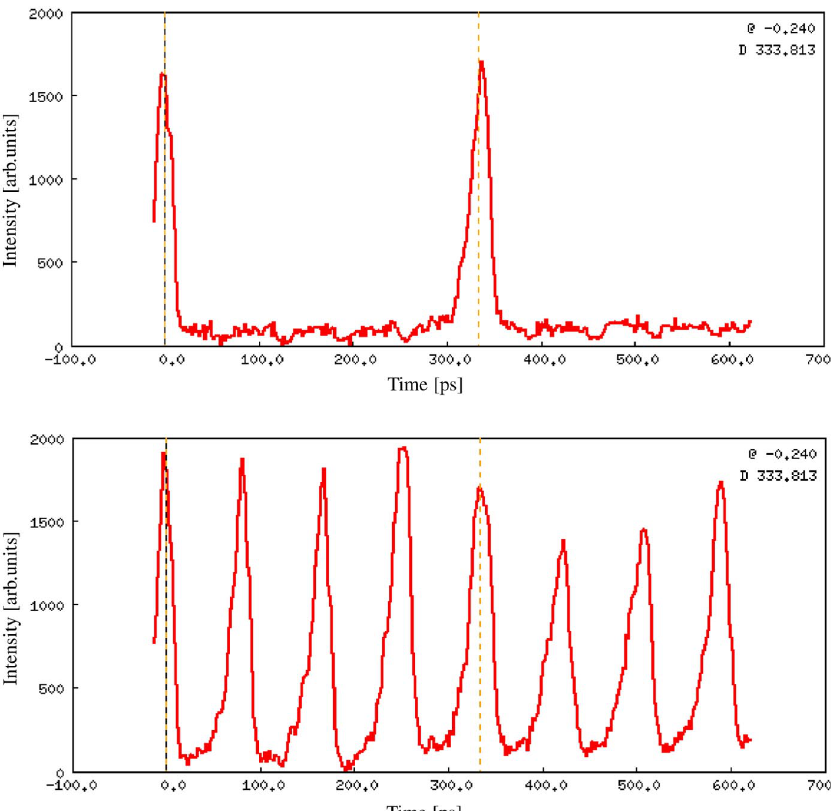
FIG. 21. (Color) Longitudinal intensity profiles for a multiplication factor 4. The two images correspond to the injection of one and four bunch trains, respectively. Amplitude variations are due to bunch current variations already present in the linac.